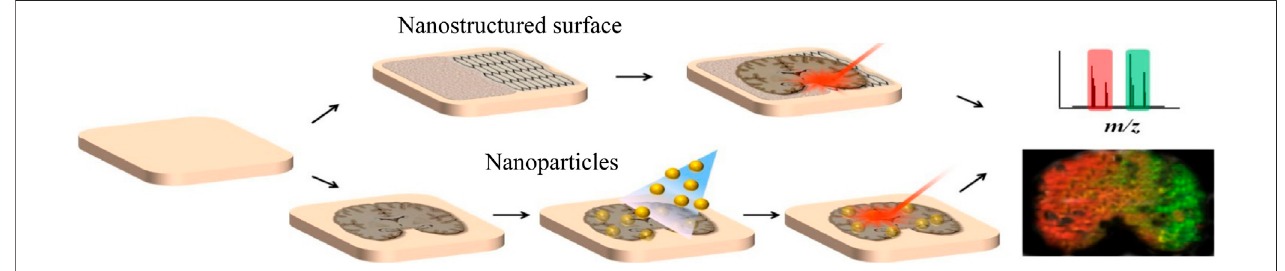
Frontiers in Chemistry |